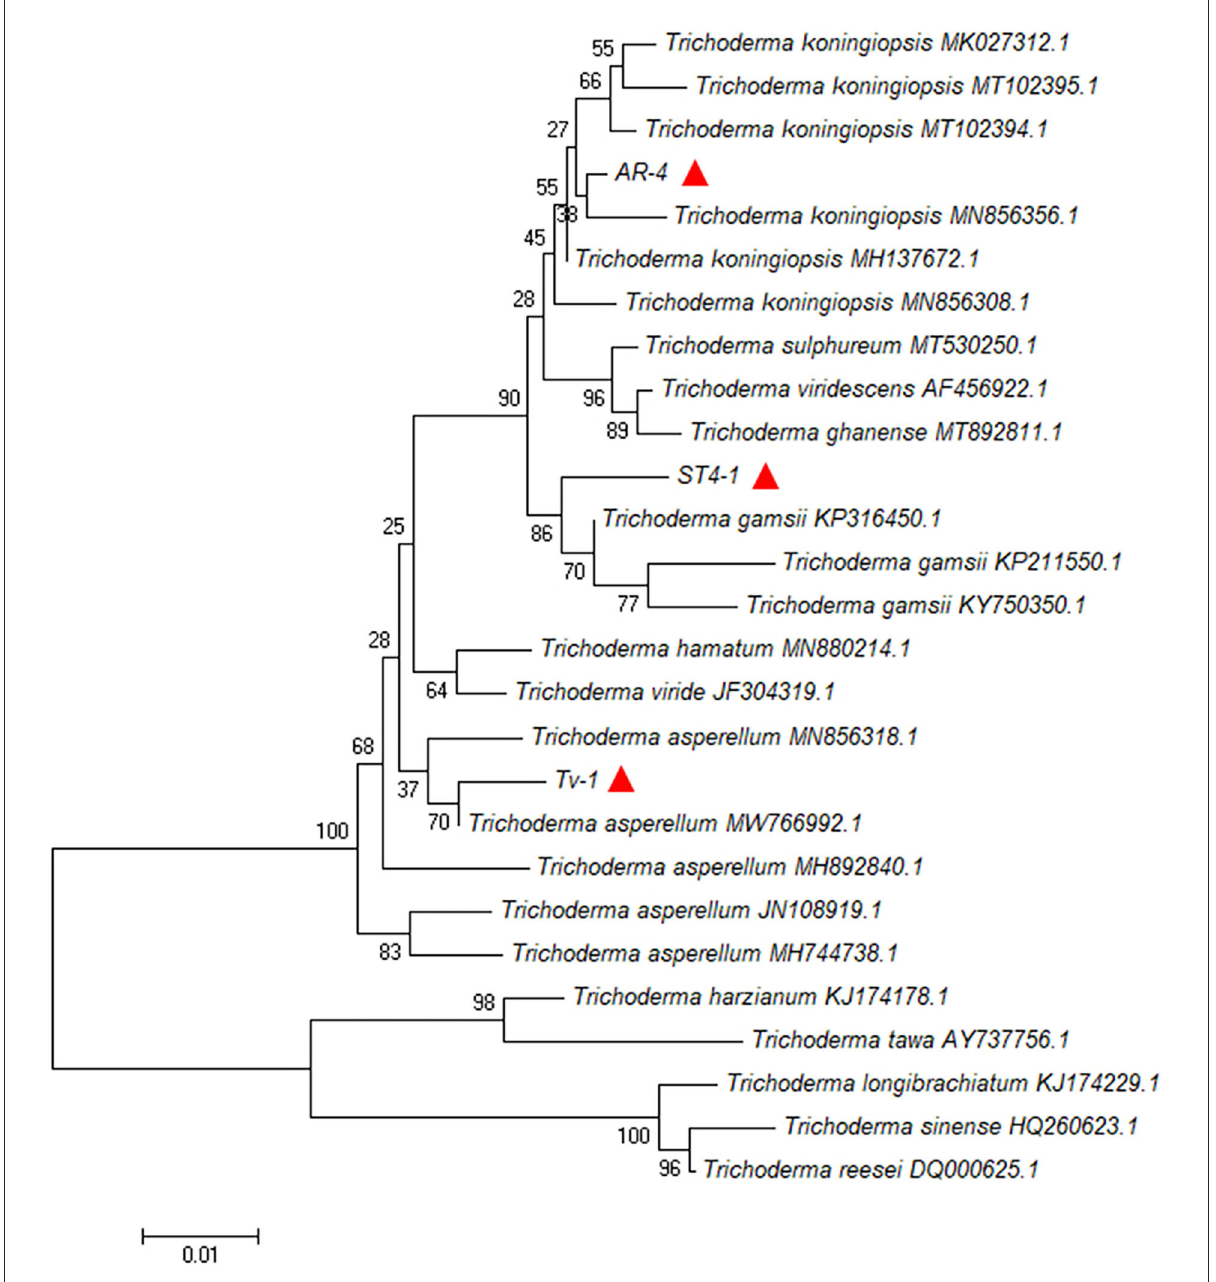
FIGURE5 Phylogenetic tree of antagonistic Trichoderma strains AR-4, Tv-1, and ST4-1 based on their ITS sequences (red triangles).